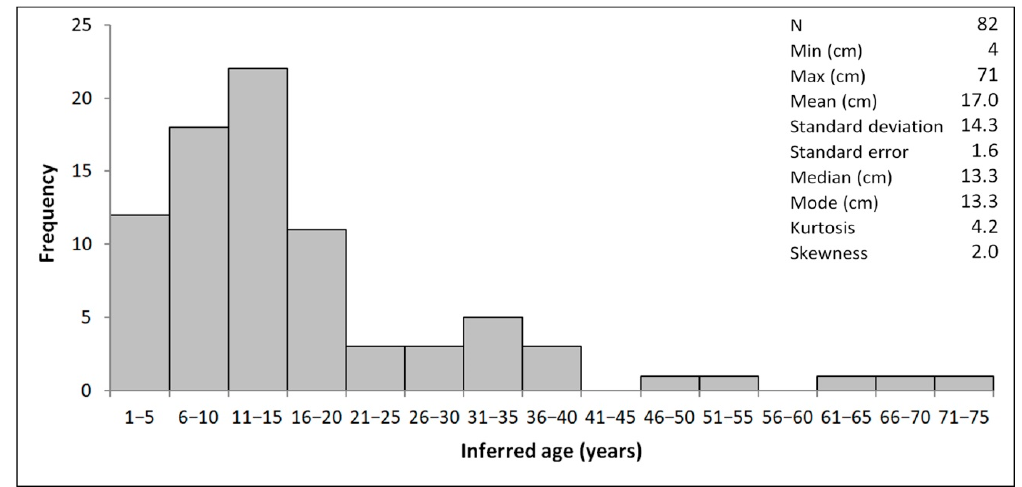
Figure 2. Size-frequency distribution of Eunicella verrucosa off Sanremo.